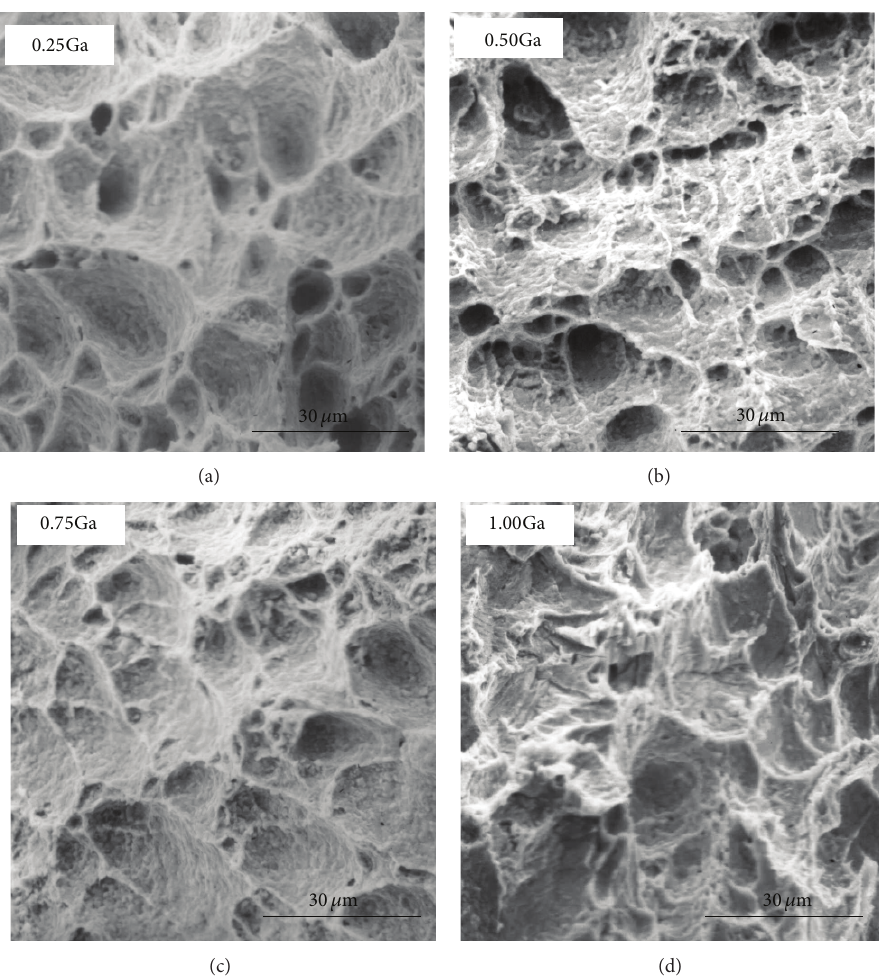
Figure 8: A higher magnification of the fracture surfaces of Sn-9Zn-0.25Ga, Sn-9Zn-0.50Ga, Sn-9Zn-0.75Ga and Sn-9Zn-1.00Ga solder